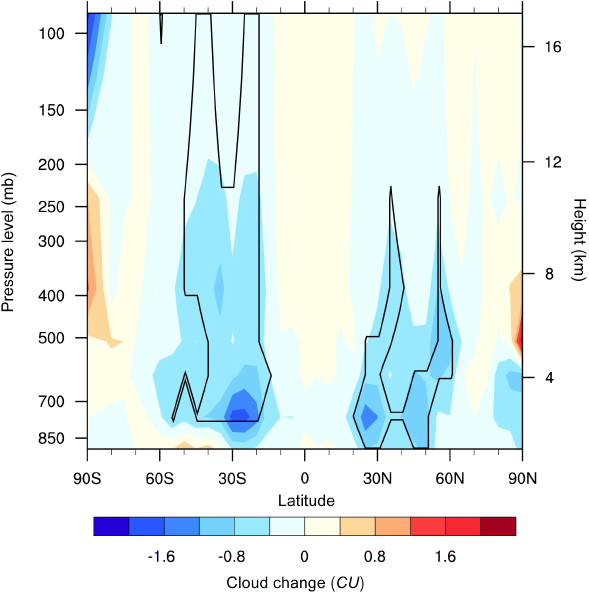
Fig. 2. A latitude/height profile of anomalous cloud cover changes occurring on the key date of the composite. Statistically signif- icant changes (above the 0.95 confidence level) are indicated by solid